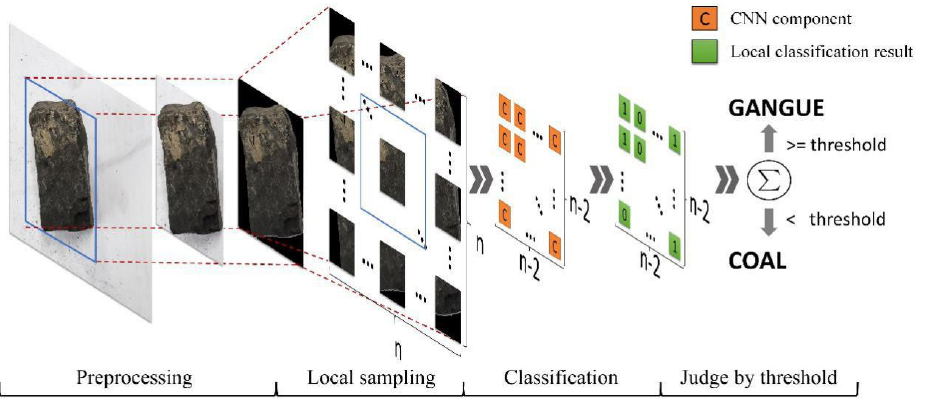
Figure 4. LTC-net